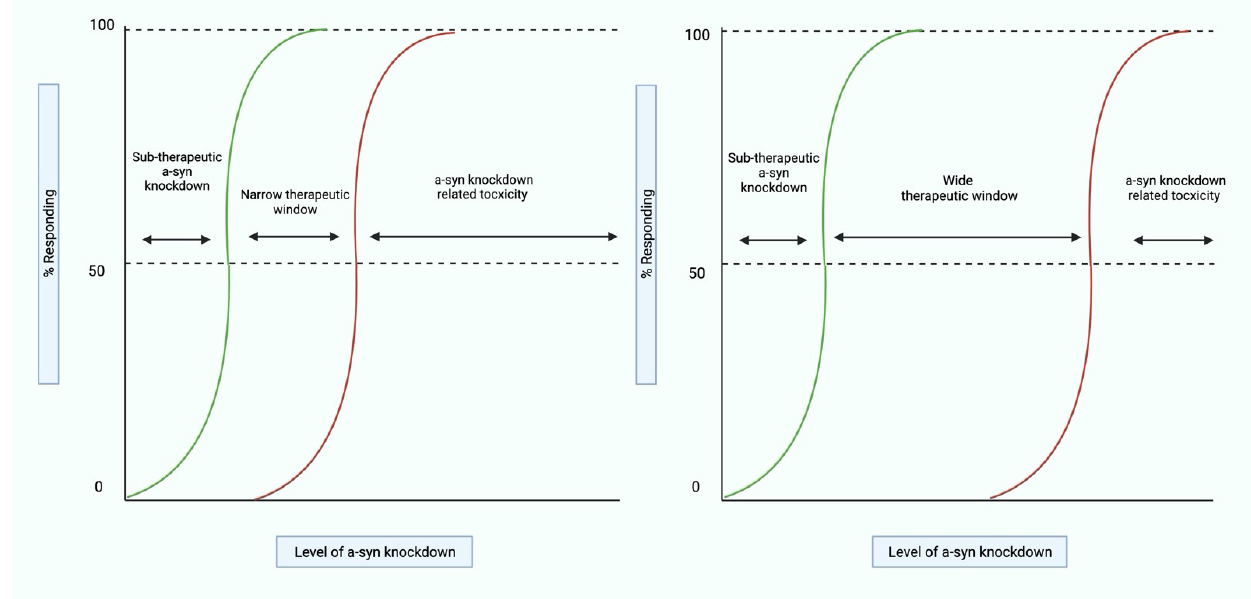
Figure 3. A therapeutic window of alpha-synuclein knockdown. The therapeutic window of alpha-synuclein knockdown needs to be defined to increase confidence in the safety and efficacy of these strategies. A sub-therapeutic level of alpha-synuclein knockdown would lead to further alpha-synuclein aggregation and related neurodegeneration. It is also possible that a toxic level of alpha-synuclein knockdown would lead to further SNpc neurodegeneration. The size of this ther-